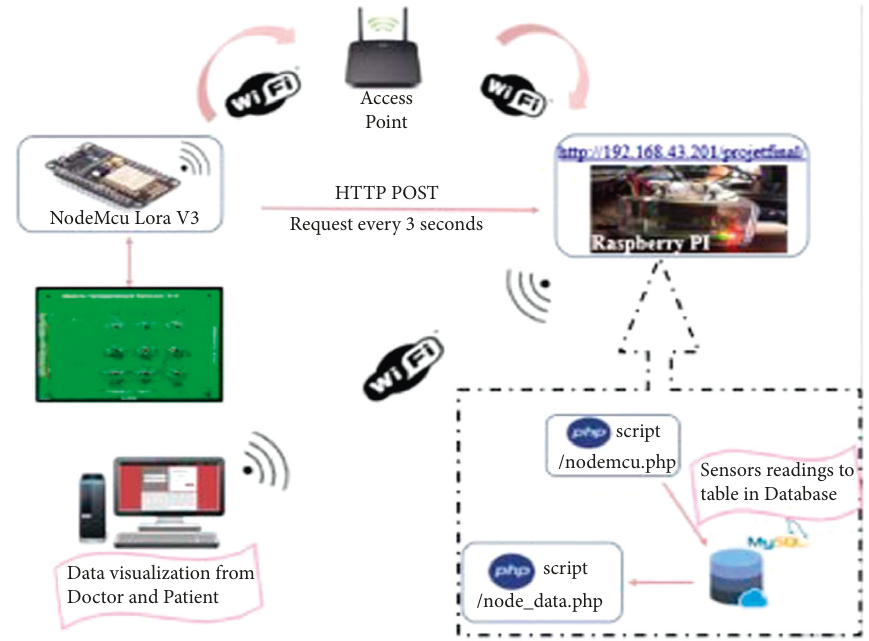
Figure 3: Various operations of IoT systems while detecting breast cancer symptoms